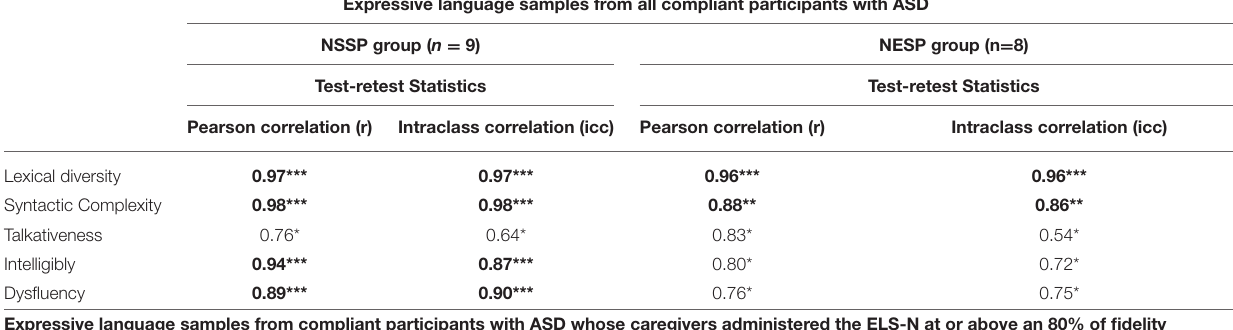
TABLE 6 | Test-retest reliability over a 4-week interval: bivariate correlations and intraclass correlations. Expressive language samples from all compliant participants with